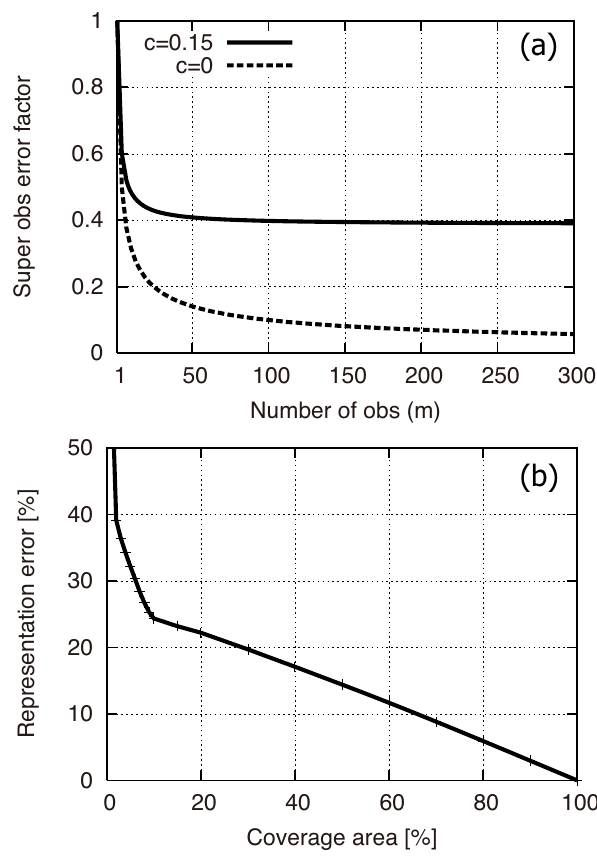
Fig. 1. (a) The error reduction factor for the super-observation as a function of number of observations, m , for different sub-grid error correlations, c = 0 (dotted line) and 15% (solid line). (b) The rep- resentativeness error multiplication factor f rep as a function of the coverage of the grid cell by OMI observations. See Eqs. (11) and (12) and Sect. 2.3.3 for